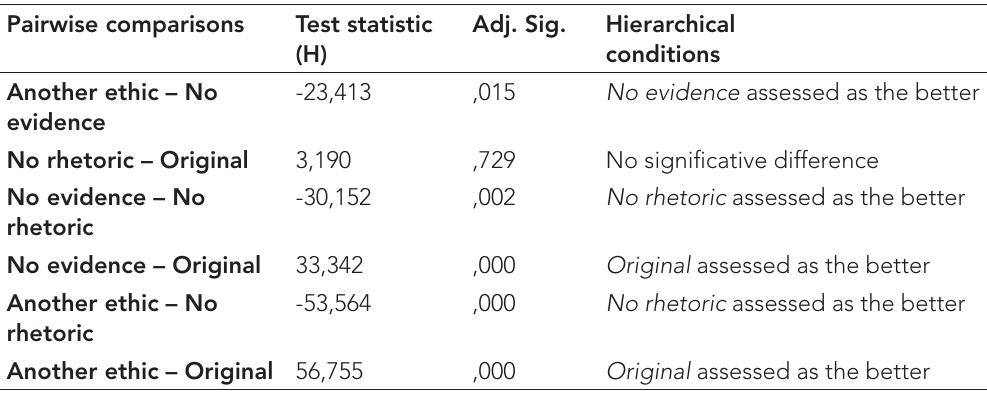
Table 3: Pairwise comparisons, Kruskal-Wallis test Pairwise